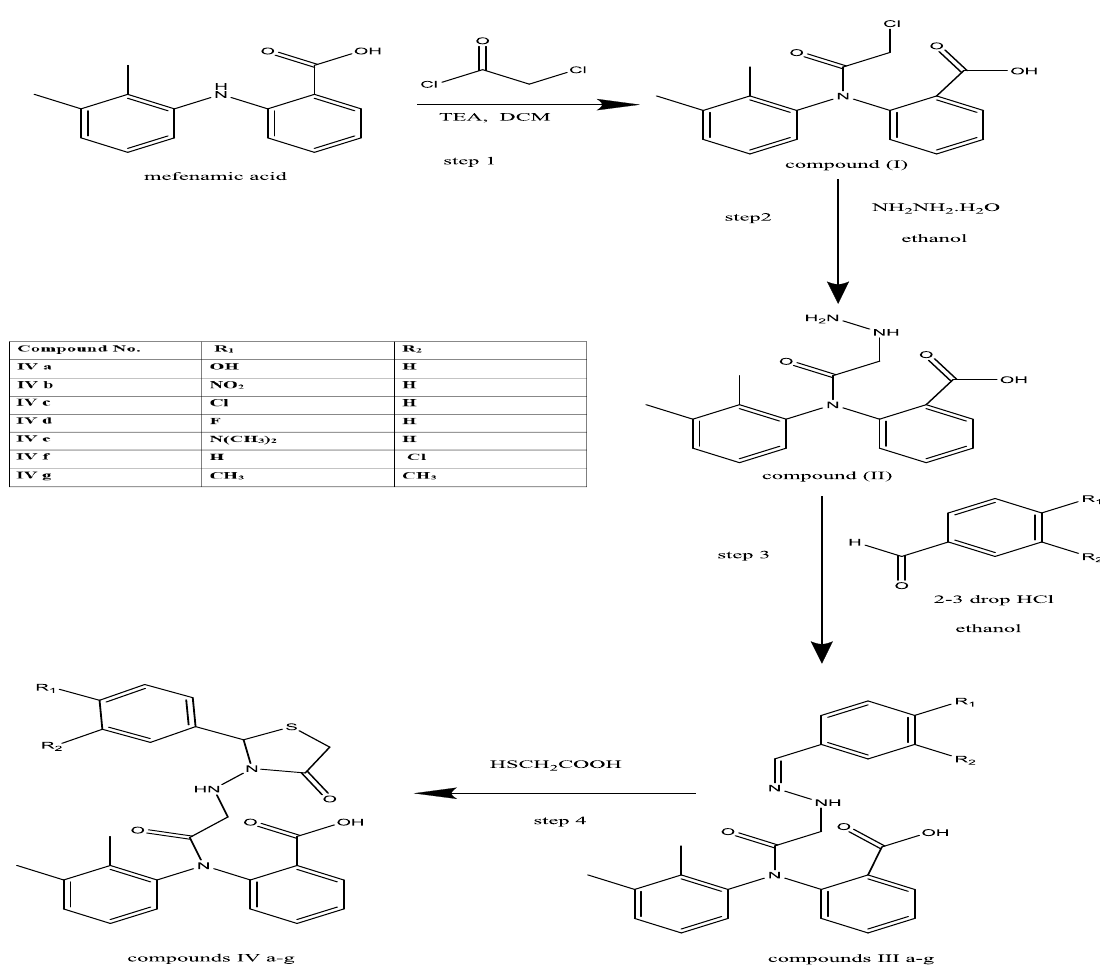
Scheme 1.Synthesis of the target compounds (IV a-g